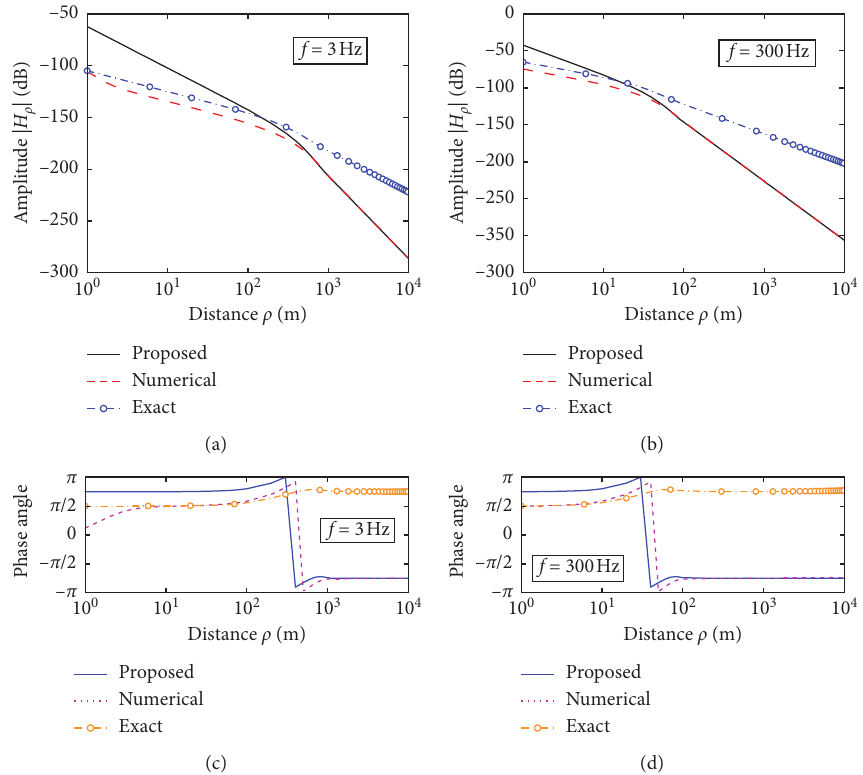
versus the propagation distance ρ with the proposed, exact, and numerical 2 ρ